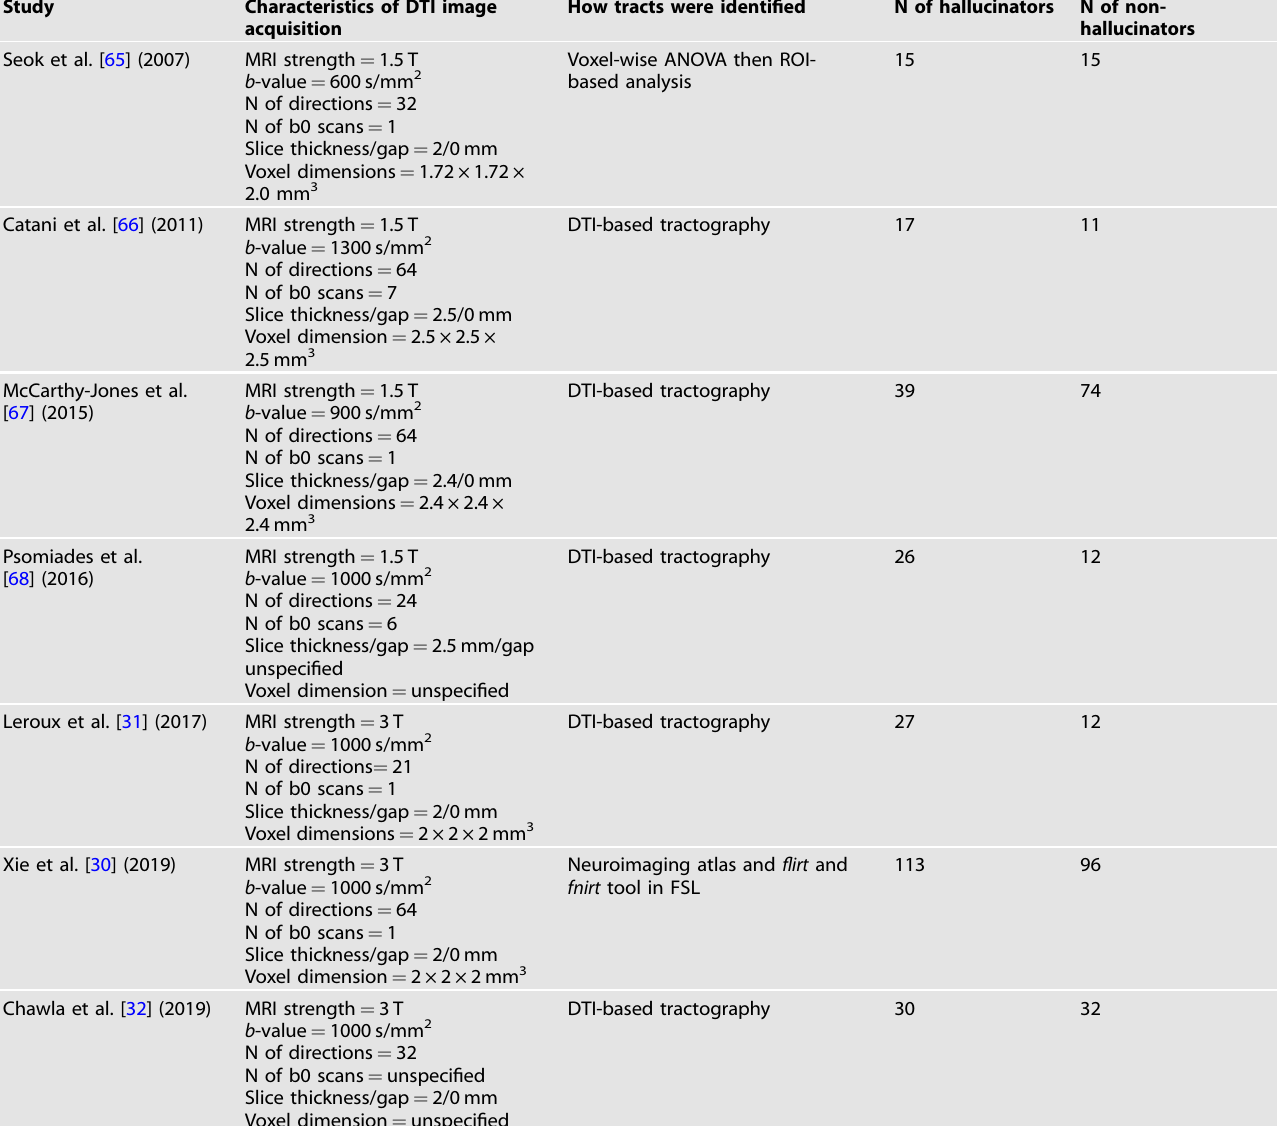
Table 6. The characteristics of the diffusion tensor imaging studies included in the meta-analyses.